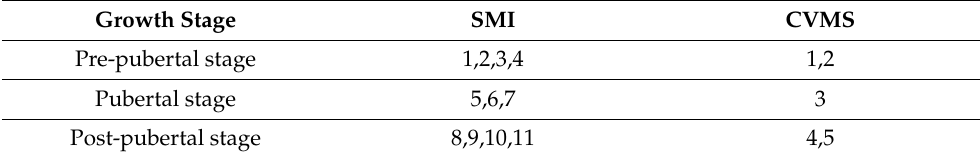
Table 1. Correspondence of the SMI and CVMS indexes according to the stages of growth and development. Growth Stage SMI CVMS Pre-pubertal stage 1,2,3,4 1,2 Pubertal stage 5,6,7 3 Post-pubertal stage 8,9,10,11